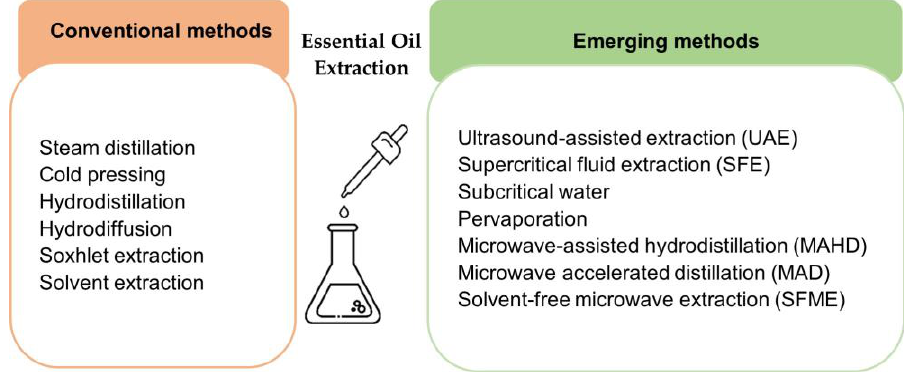
Figure 4. Schematic of essential oil extraction technologies.